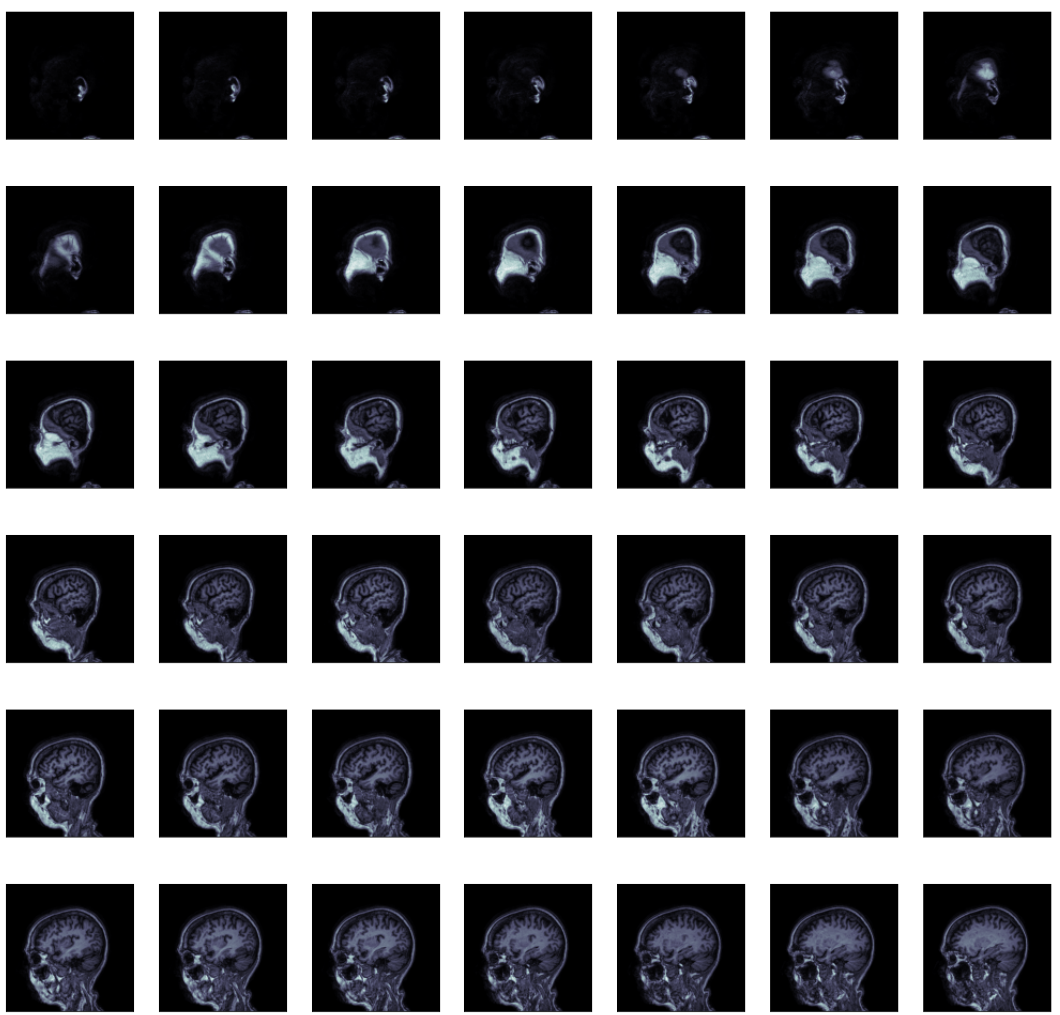
Figure 1. Volumetric data from a subject’s MRI (extracted